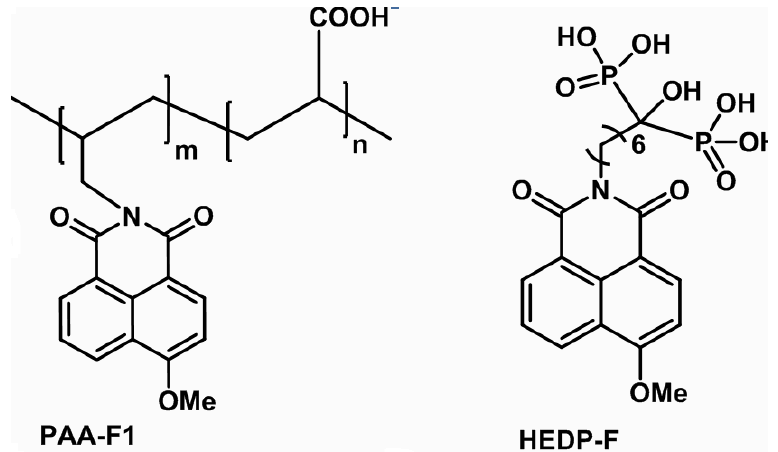
Figure 1. PAA-F1 and HEDP-F molecular structures.